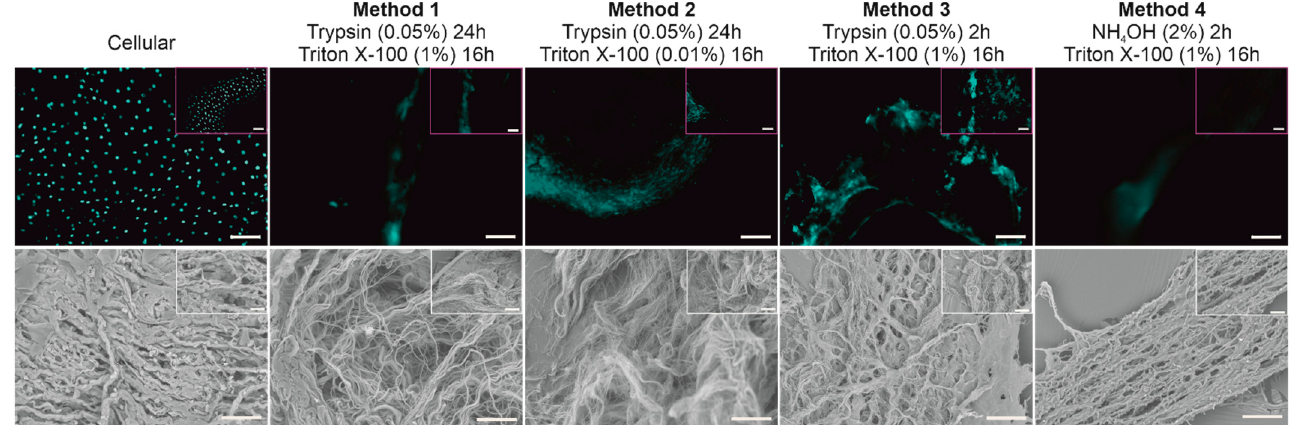
Figure 2. Representative apotome fluorescent images ( Top ) and scanning electron micrographs ( Bottom ) of bovine trabecular meshwork treated with four different decellularization protocols with comparison to cellular control. Fluorescent staining of cell nucleus with DAPI (blue). (Top: magnification x10, scale bar = 100 µm; inset magnification x20, scale bar = 50 µm; Bottom: magnification x1000, scale bar = 50 µm; inset magnification x2500, scale bar = 20 µm).